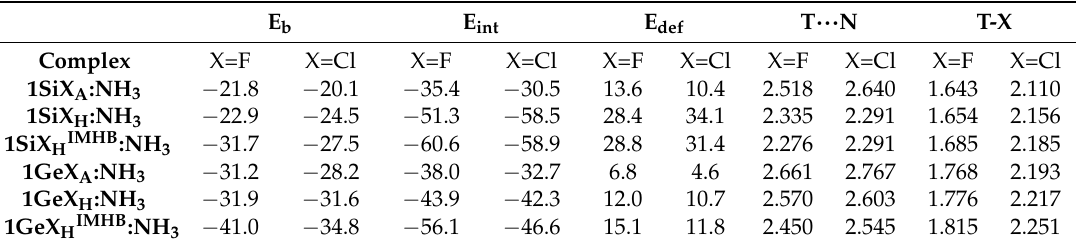
1GeX HIMHB :NH 3 −